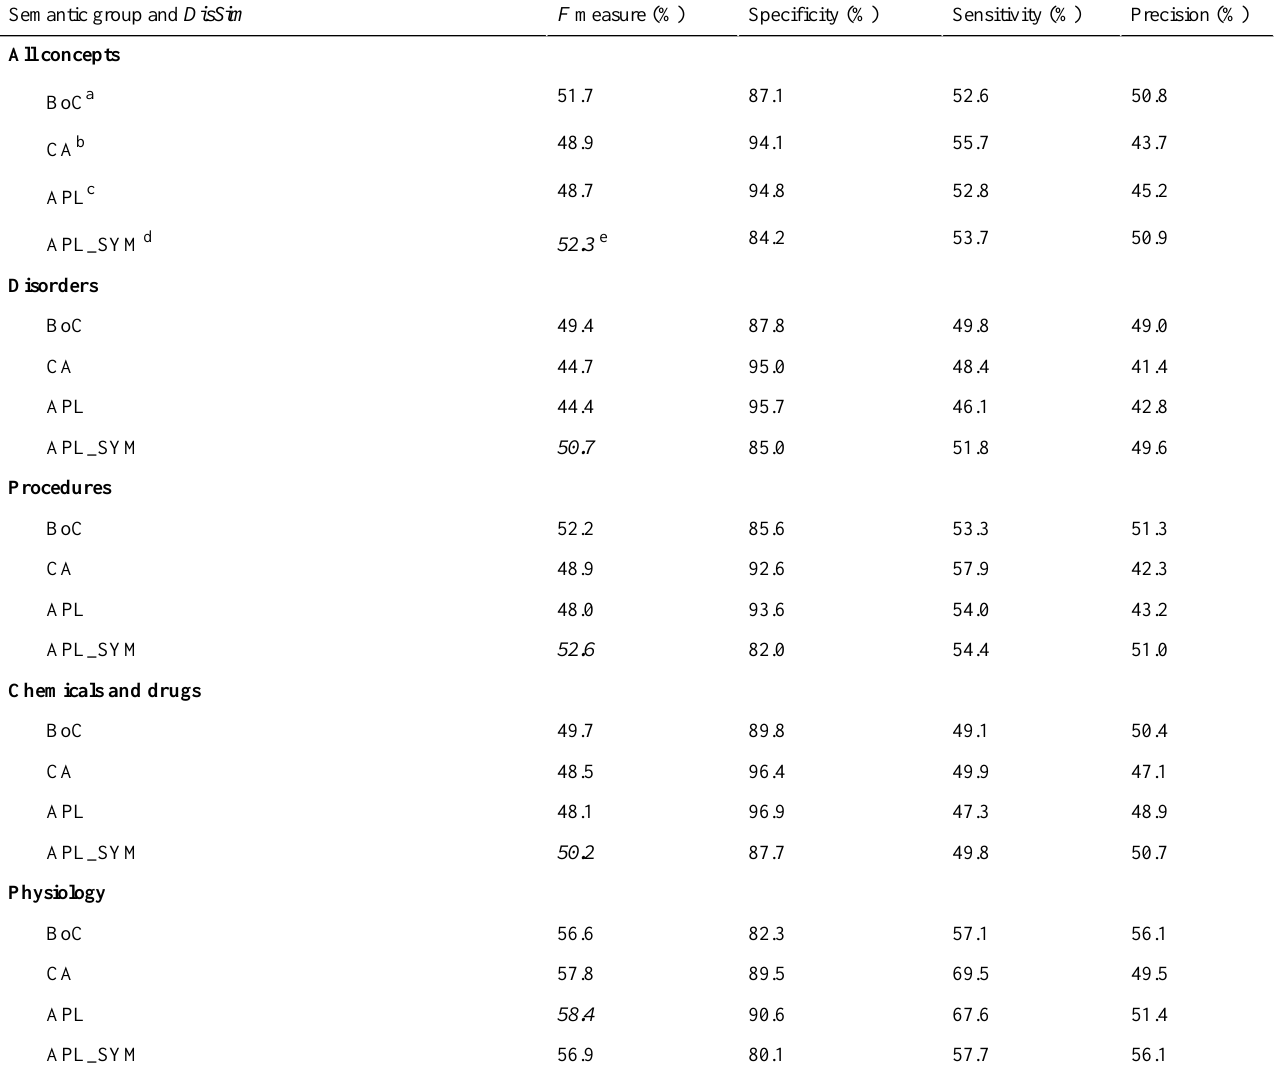
Table 2. The results for the testing data set separated by semantic group, using the parameters tuned on the training data set for fresh and not fresh